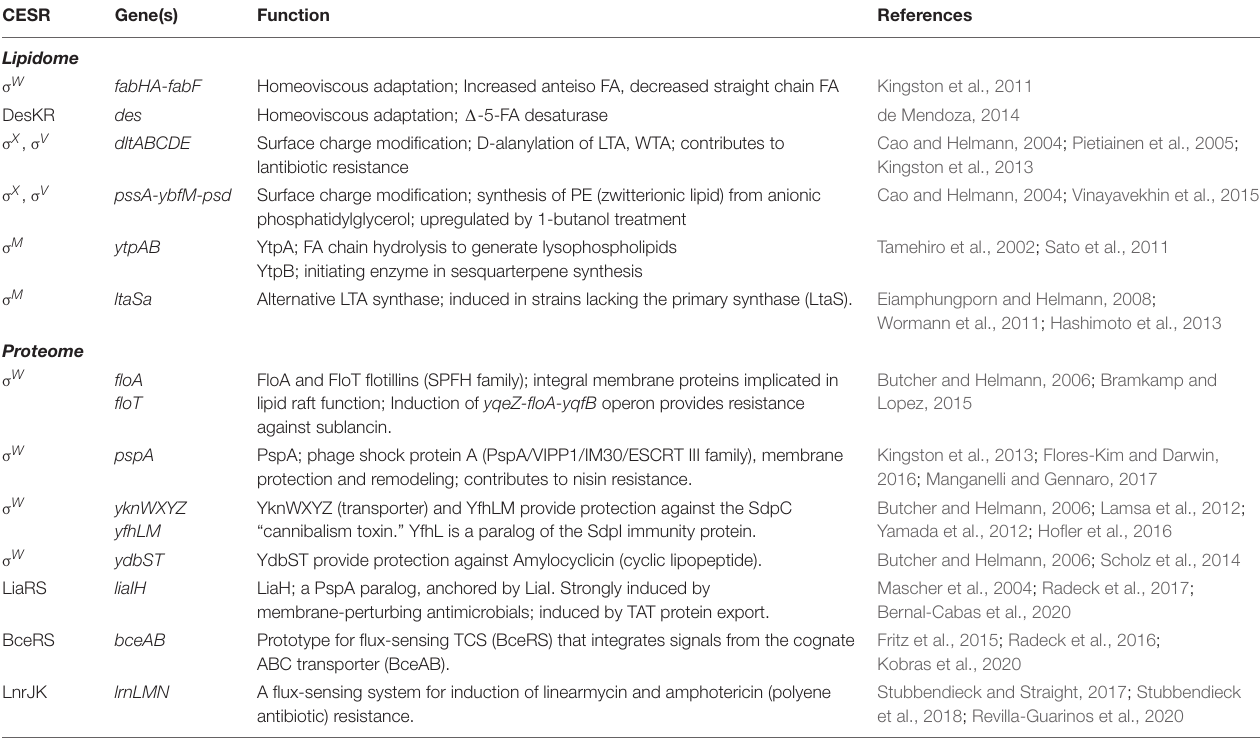
TABLE 1 | Representative B. subtilis CESRs that modify the lipidome and membrane proteome 1